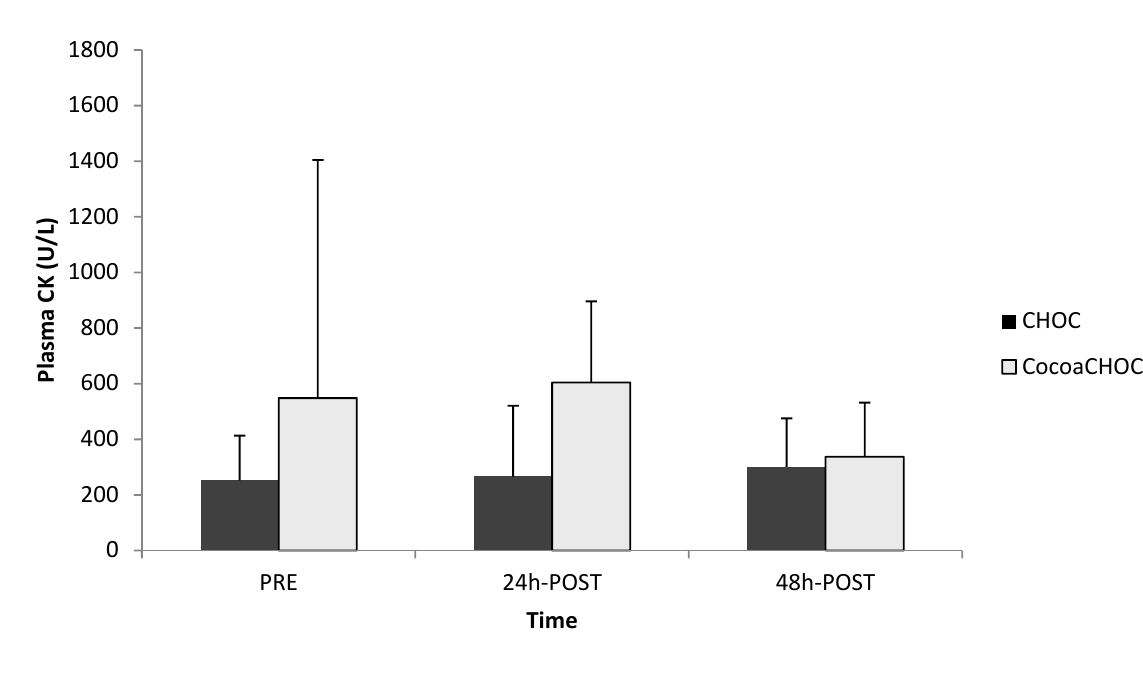
Figure 1. Creatine kinase (CK) levels for each trial (CKPRE, CK 24 h-POST, and CK 48 h-POST). Note: CHOC, chocolate milk; CocoaCHOC, cocoa beverage; CK, creatine kinase; U/L,